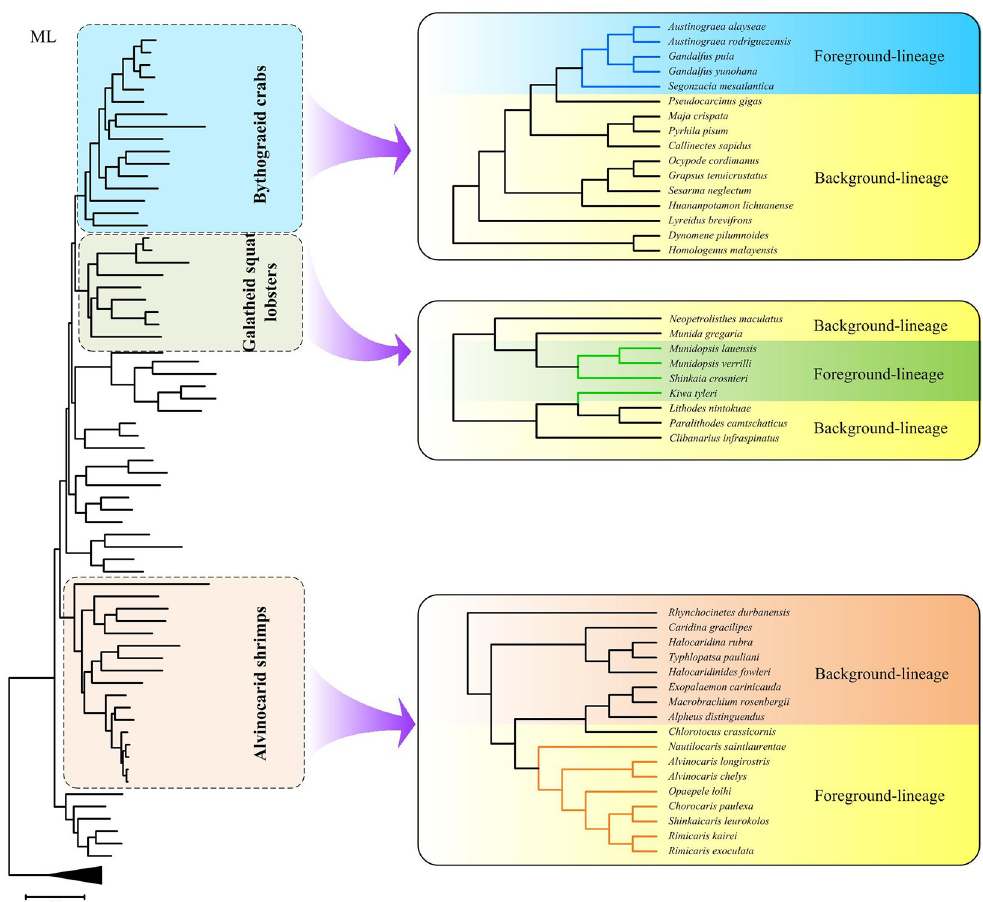
Fig 1. Phylogenetic trees used for selection analyses of mitochondrial OXPHOS genes in Bythograeidae, Galatheoidea and Alvinocarididae, respectively. The foreground-lineages were marked in blue (Bythograeidae), green (Galatheoidea) and orange (Alvinocarididae) and the background-lineages were marked in